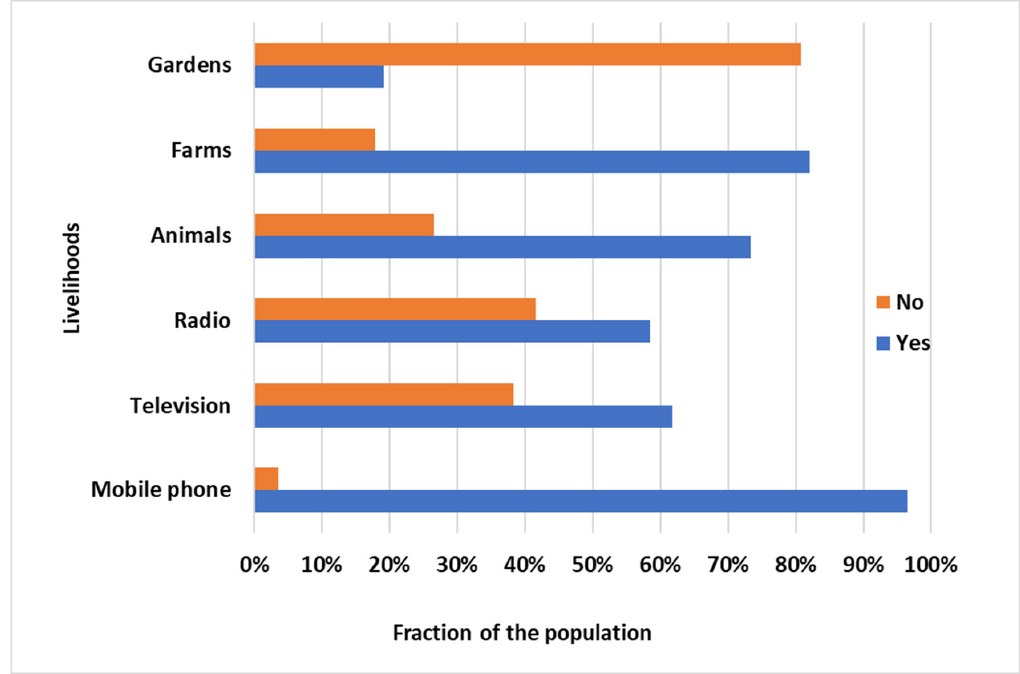
Figure 2. Livelihoods of surveyed communities in the height municipalities under study (Tounouga, Namaro, Ouro-Ghéladjo, Kiéché, Gothèye, Guéchémé, Tessa, and Falmèye).